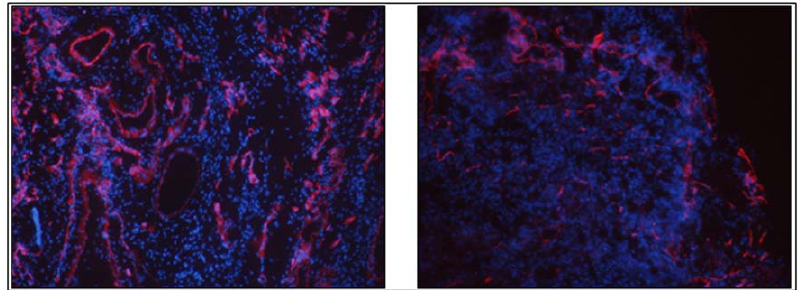
Figure 4. The anti-angiogenic activity of Frondoside A in the xenograft tumor: Immuno-histochemical staining of lung xenograft tumors for CD31 (microvessel density).